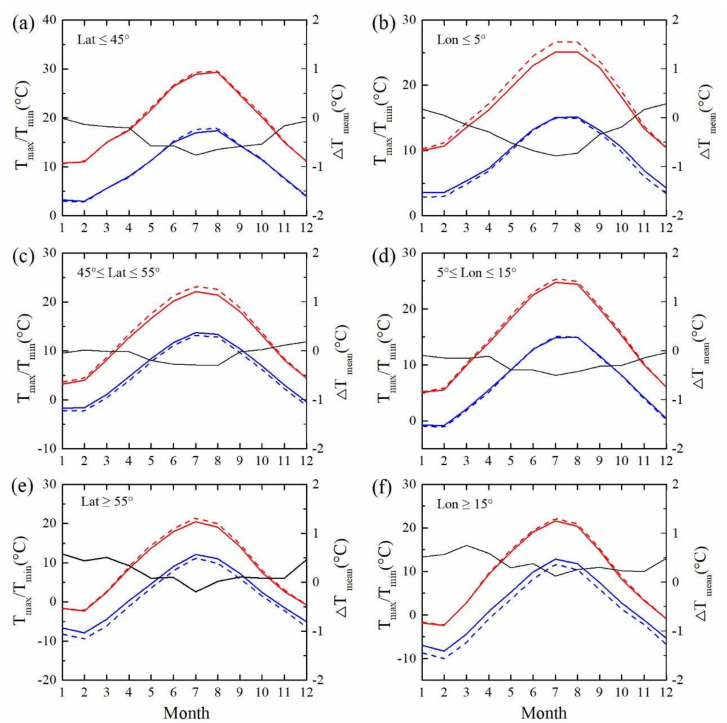
Figure 5. Comparison of seasonal variations in daily maximum, daily minimum and daily mean temperature differences in three latitudinal ( a ) south of 45 ◦ N, ( c ) between 45 ◦ N and 55 ◦ N, ( e ) north of 55 ◦ N, and longitudinal ( b ) west of 5 ◦ E, ( d ) between 5 ◦ E and 15 ◦ E, ( f ) east of 15 ◦ E ranges. The red solid and red dashed lines indicate Tmax for forests and open lands, respectively. The blue solid and blue dashed lines indicate Tmin for forests and open lands, respectively. The black solid line indicates the Tmean difference from forests minus open